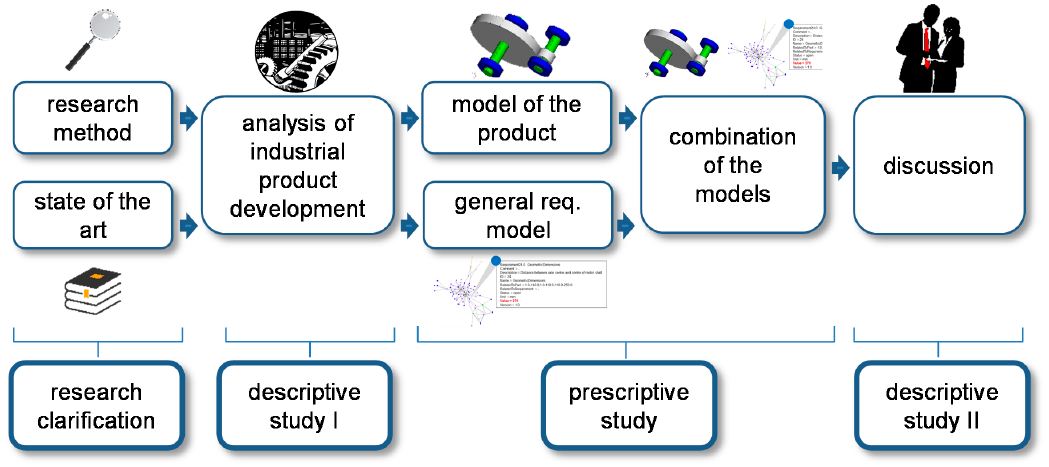
Figure 4. Research structure and structure of this paper.